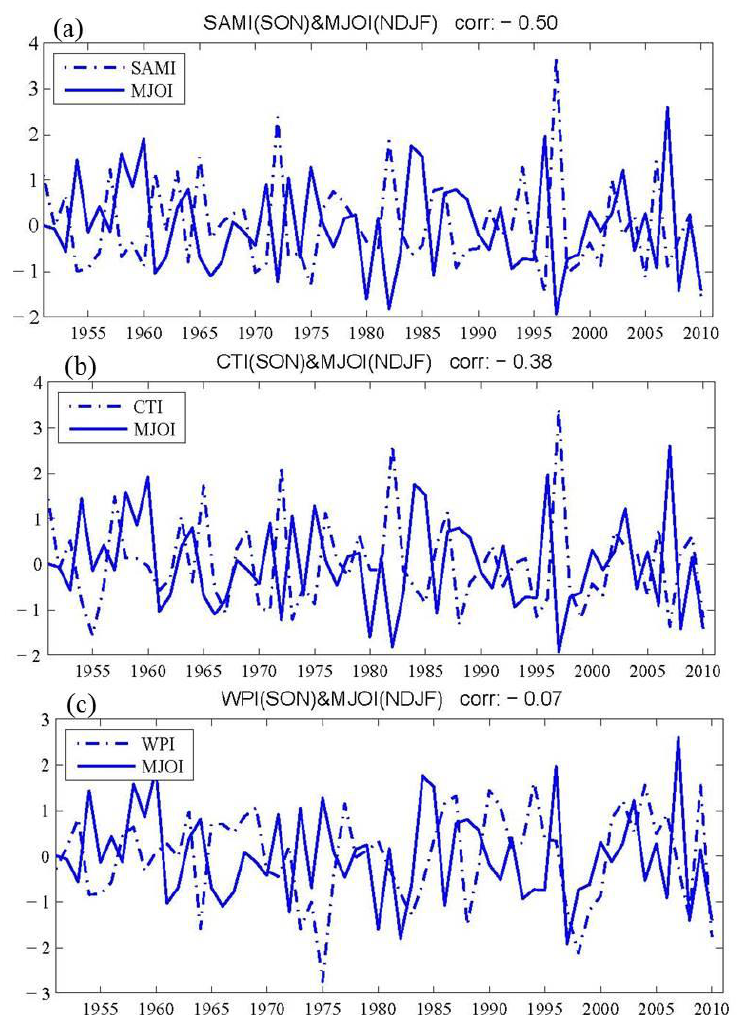
Figure 5. Correlation coefficients of the winter MC–MJO index with the autumn ( a ) SAMI (surface PIOAM associated mode index), ( b ) CTI (Cold Tongue ENSO index), and ( c ) WPI (Warm Pool ENSO index).